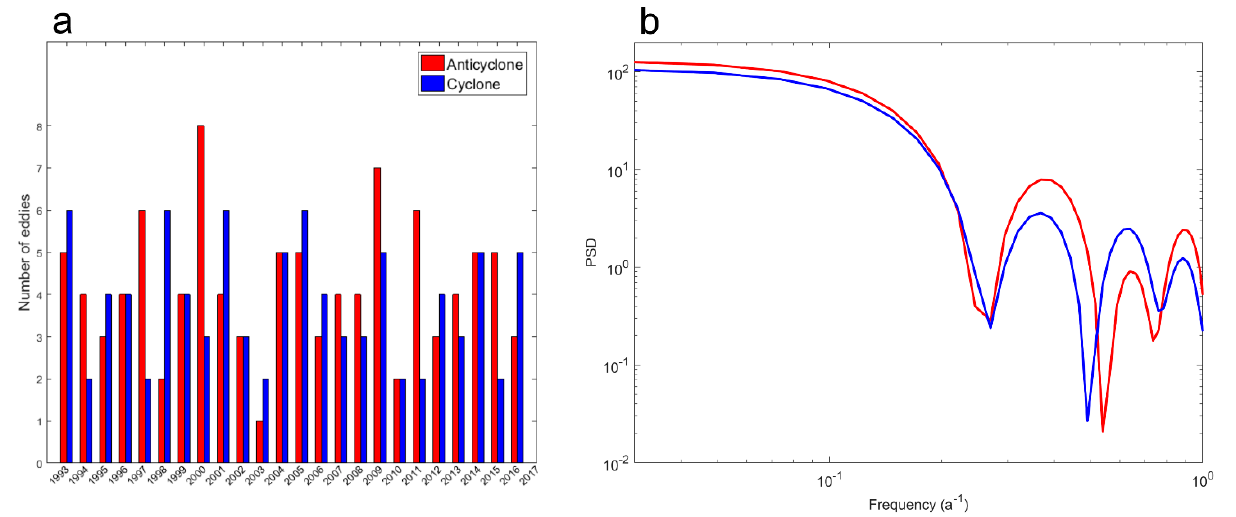
Figure 2. Histogram of the number of mesoscale eddies in the study area from 1993 to 2016: ( a ) power spectral density (PSD) of the mesoscale eddy number; ( b ) red and blue bars in ( a ) indicate anticyclonic and cyclonic eddies, respectively. The red and blue curves in ( b ) are for anticyclonic and cyclonic eddies, respectively.